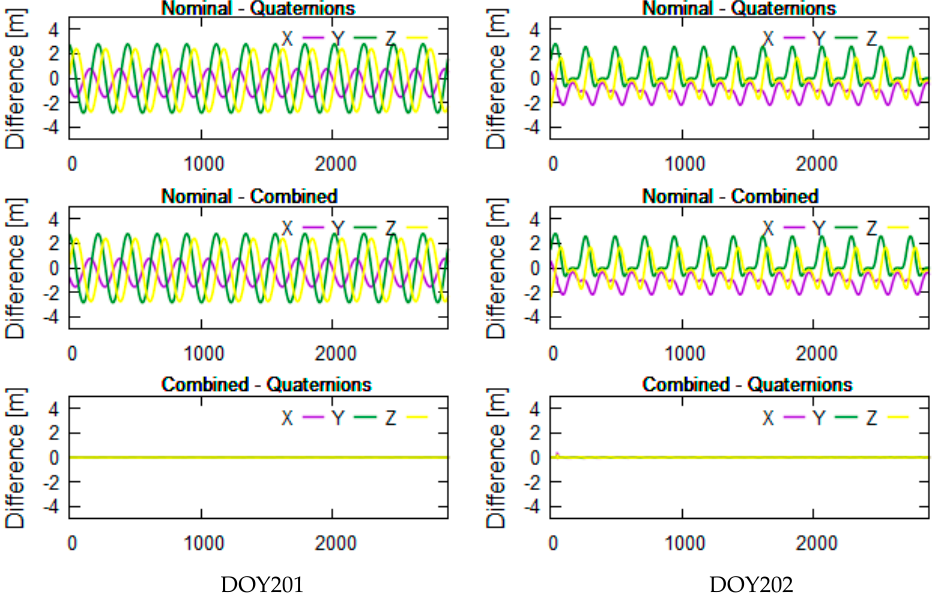
Figure 6. Differences in PCO correction using different attitude modes near - 14.6° .